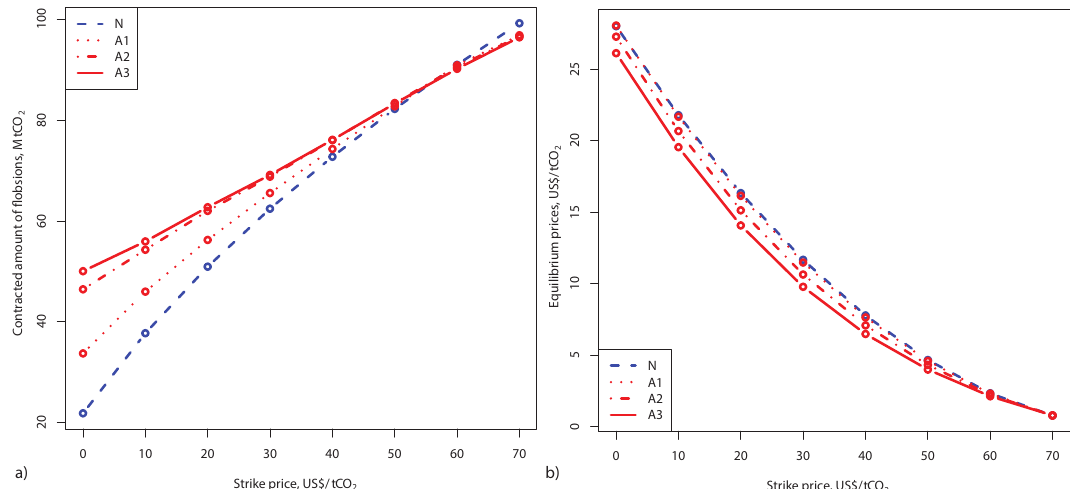
Figure 5. Contracted amounts ( a ) and equilibrium prices ( b ) of flobsions with respect to strike price p min for benefit-sharing ratio δ = 0.7, CO 2 distribution (19) and opportunity cost (20) with K = 0.9. Comparison of risk-neutral case N with risk-averse cases A1, A2 and A3.